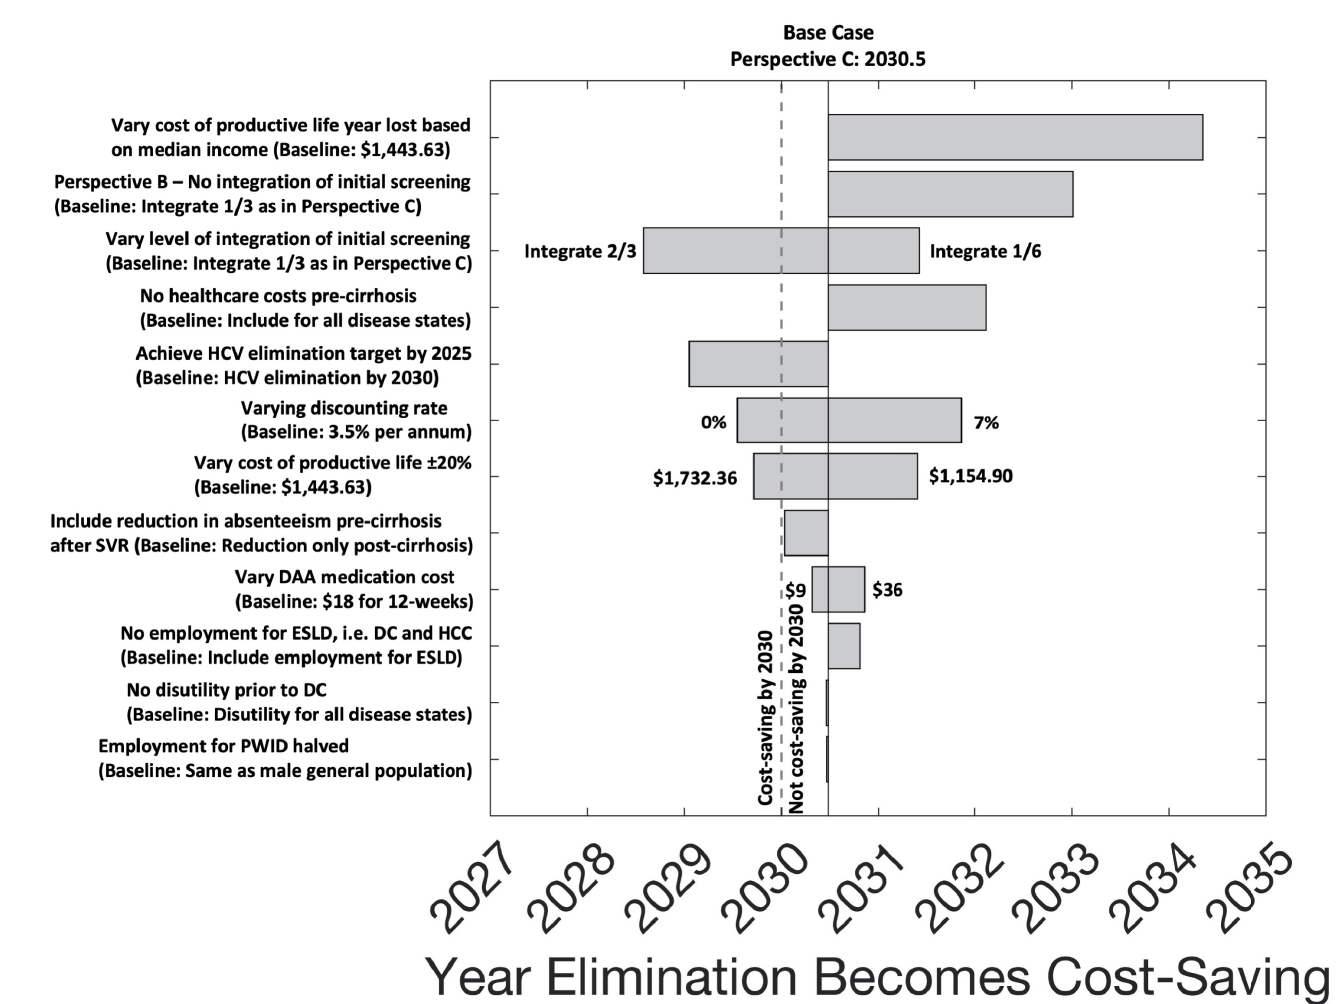
Fig 3. Univariate sensitivity analyses on the year that the HCV EL scenario becomes cost-saving. For each sensitivity analysis scenario, the estimated year that HCV elimination becomes cost-saving or, equivalently, the year when overall net economic benefit becomes positive, is taken from economic perspective C, compared to SQ. The bars show the median across 1,151 model runs for the various sensitivity analyses. DAA, direct-acting antiviral; DC, decompensated cirrhosis; EL, elimination; ESLD, end-stage liver disease; HCC, hepatocellular carcinoma; HCV, hepatitis C virus; PWID, people who inject drugs; SQ, status quo; SVR, sustained virological